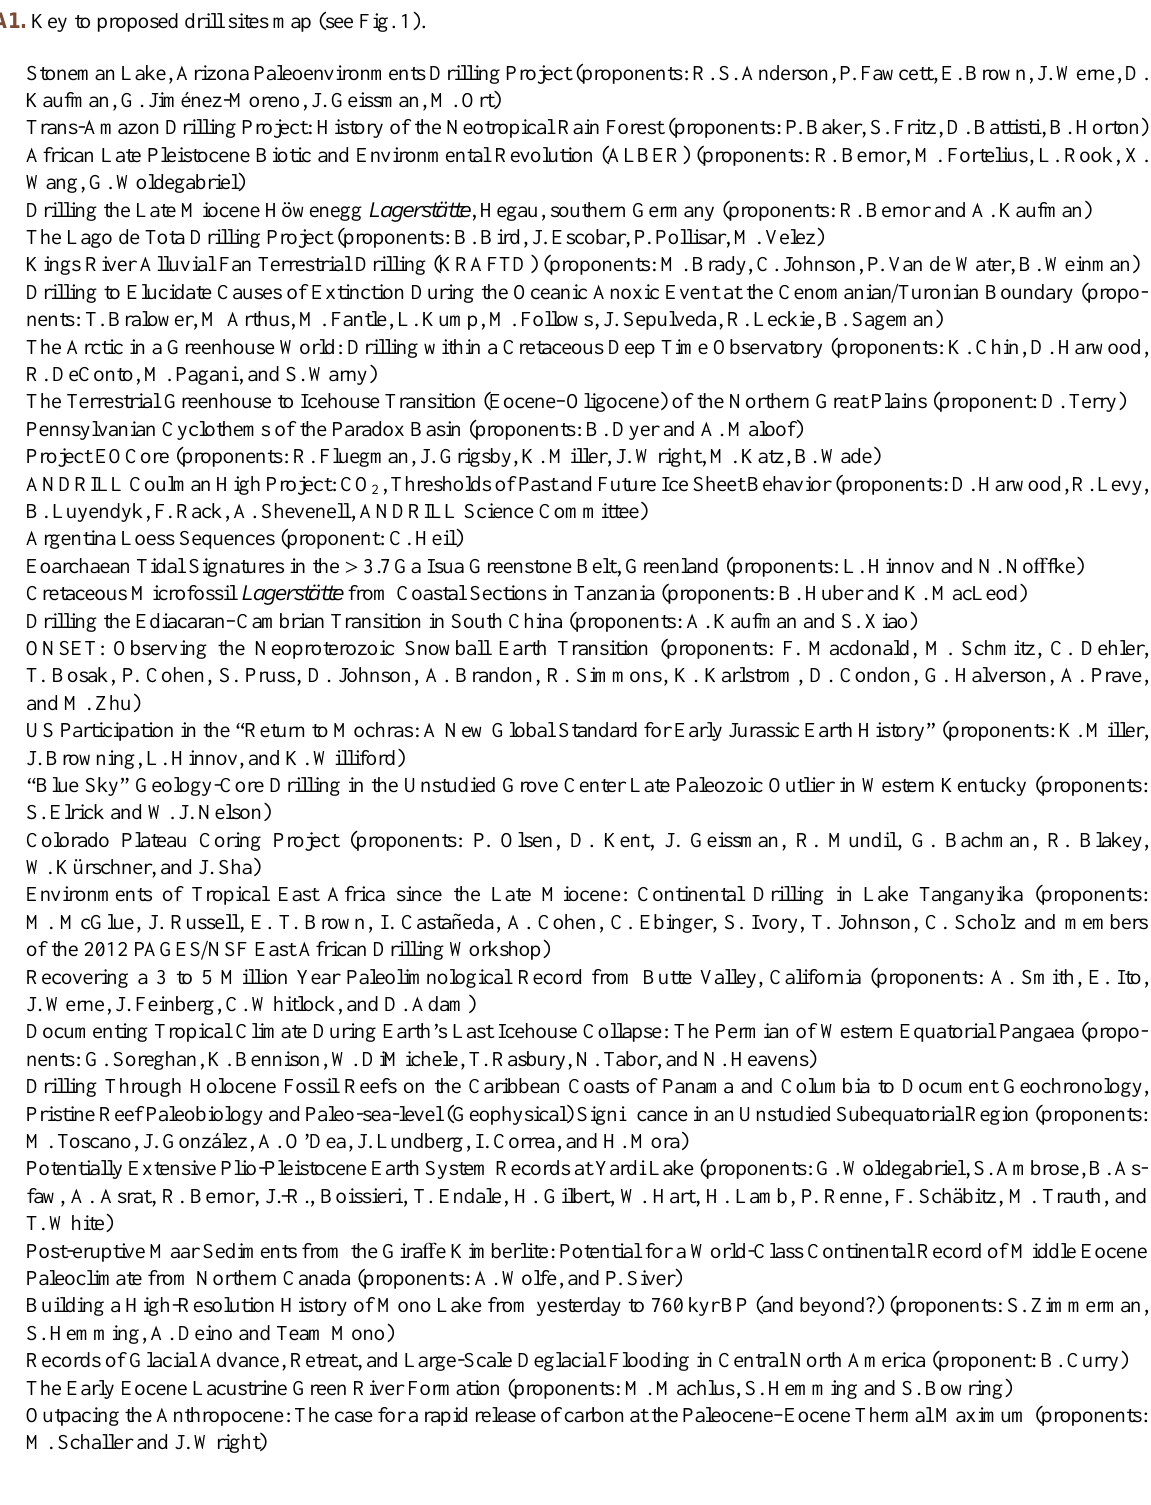
Table A1. Key to proposed drill sites map (see Fig.